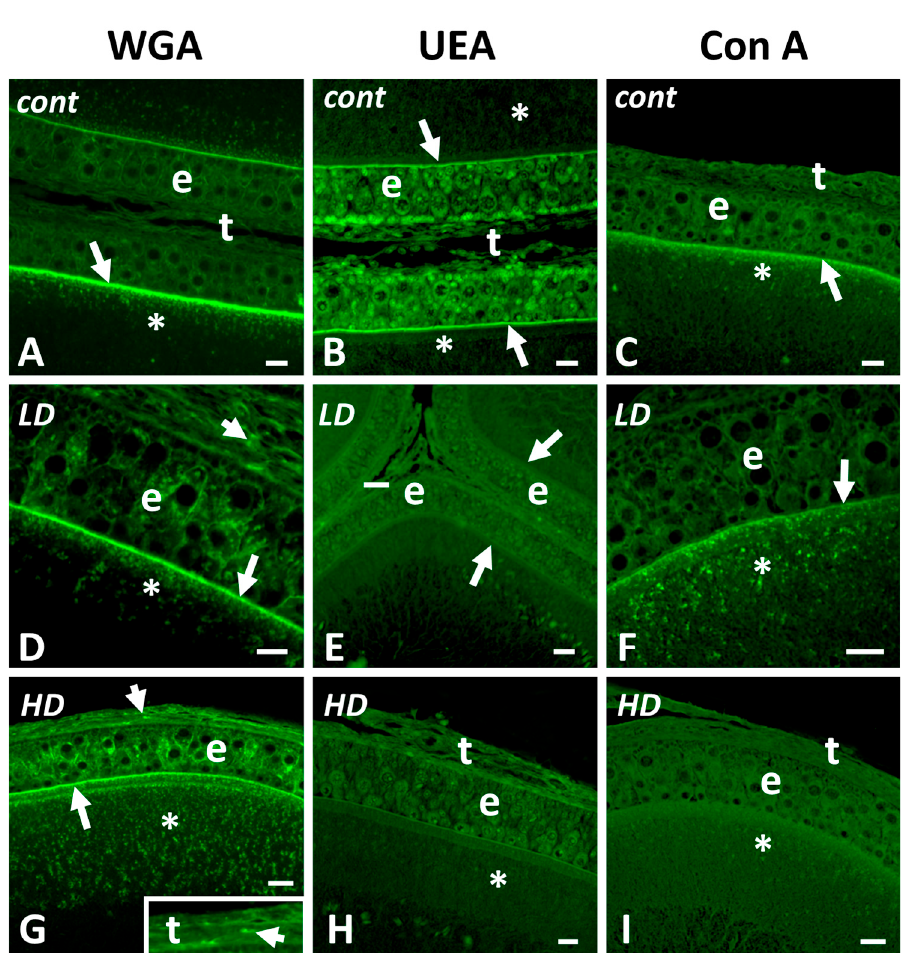
Figure 5. Effects of glyphosate (low LD and high HD doses) on carbohydrate distribution in ovarian follicles. Staining with fluorescent lectins. ( A ) Stained zona pellucida (arrow) and oocyte cortical granules (*); unstained theca (t) and epithelium (e). ( B ) Stained zona pellucida (arrows), follicular epithelium (e), and theca (t); unstained oocyte cortical cytoplasm (*). ( C ) Stained zona pellucida (arrow) and cortical granules (*); unstained epithelium (e). ( D , G ) Stained theca cells (t), zona pellucida (arrow), and cytoplasm of epithelial cells (e); note the increase in cortical granules (*). Inset: detail of theca with stained cells (arrowhead). ( E , H ) Unstained theca (t), epithelium (e), and oocyte cytoplasm (*). ( F , I ) Disappearance of staining on zona pellucida (arrow) and cortical granules (*). WGA stains N-Acetyl-glucosamine, UEA stains fucose, and Con A stains mannose. Scale bars: ( A-D; F-I ) 20 µm; ( E ) 40 µm.